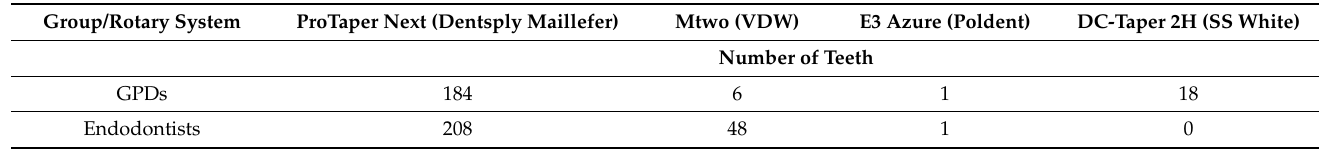
Table 3. The rotary systems used during RCT.